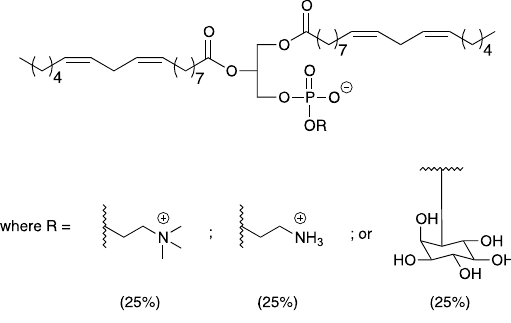
Figure 1. Chemical structure of asolectin.